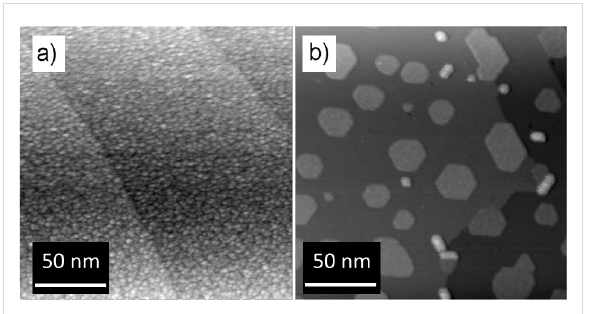
Figure 6: STM images of a cerium oxide ultrathin film on Pt(111) (a) as grown, acquired at 2.0 V and 0.03 nA, and (b) after annealing in UHV at 1020 K, acquired at 2.5 V and 0.03